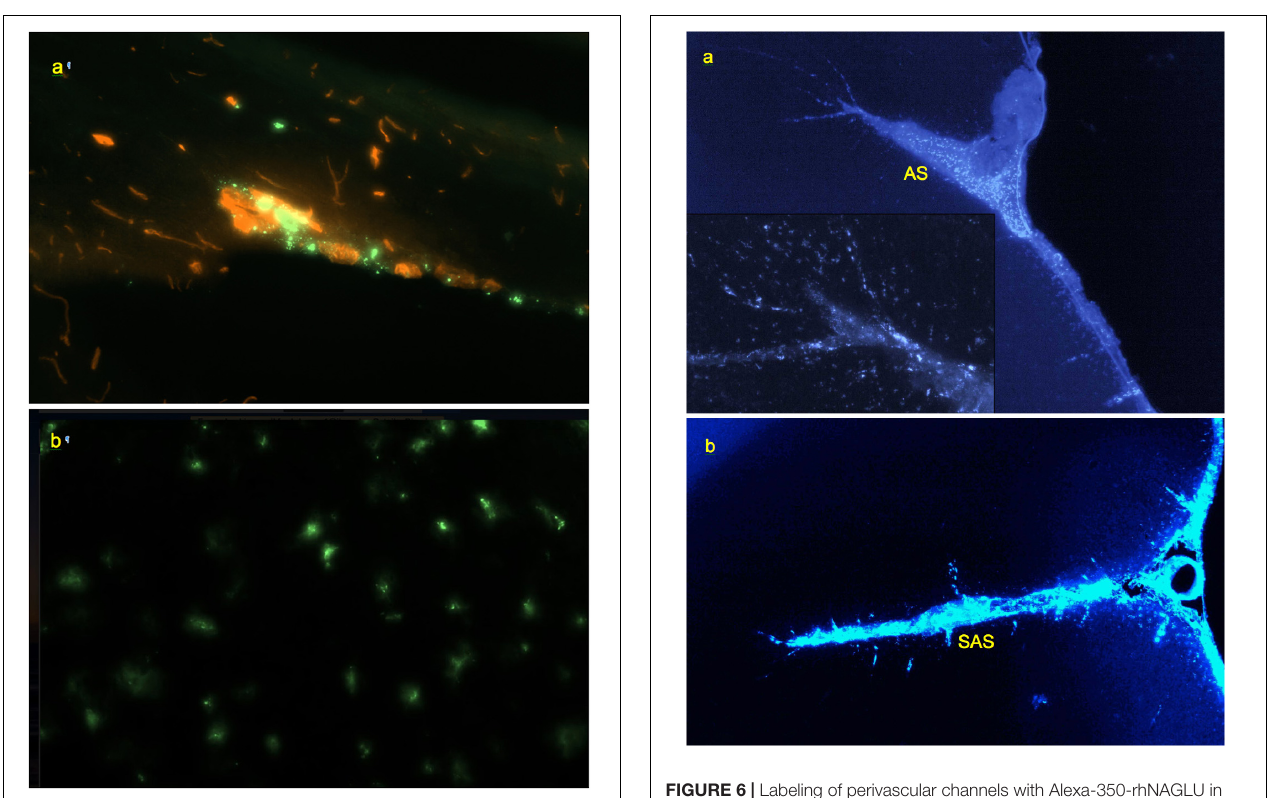
FIGURE 5 | (a) Perivascular channel at the dorsal surface of olfactory bulb (green); blood vessels stained with Texas Red; 0.9 mm × 0.6 mm; sagittal slice. (b) Pineal gland: non-linear pattern of tracer deposition; 0.9 mm × 0.6 mm, transverse slice; no co-staining.